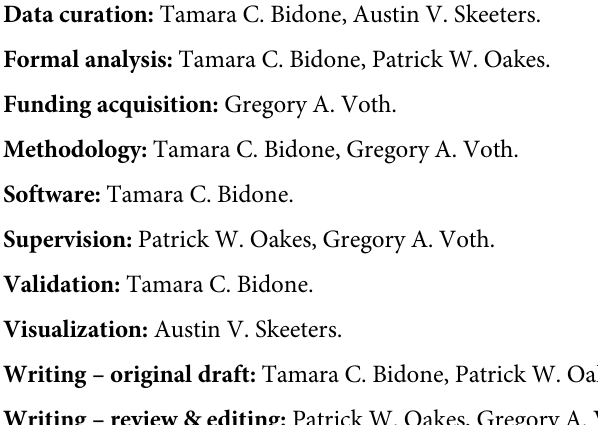
S2 Fig. Volume exclusion effects between integrins do not change ligand binding and trac- tion stress as a function of actin flow. (A) Average fraction of ligand-bound integrins as a function of actin flow speed and percentage of β -1 integrins in a system of β -3 integrins. (B) Corresponding average nearest neighbor distance between ligand-bound integrins. (C) Corre- sponding average tension per integrin. (D) Distribution of tension on ligand-bound integrins for the two integrins types, using 80% β -1 and 20% β -3 integrins and 10 nm/s actin flow. Data are computed between 1–20 s of simulations, using a weak repulsive potential (1 pN) between integrins closer than 1 nm. Panels E-H show data as in panels A-D for implemented repulsive forces of 10